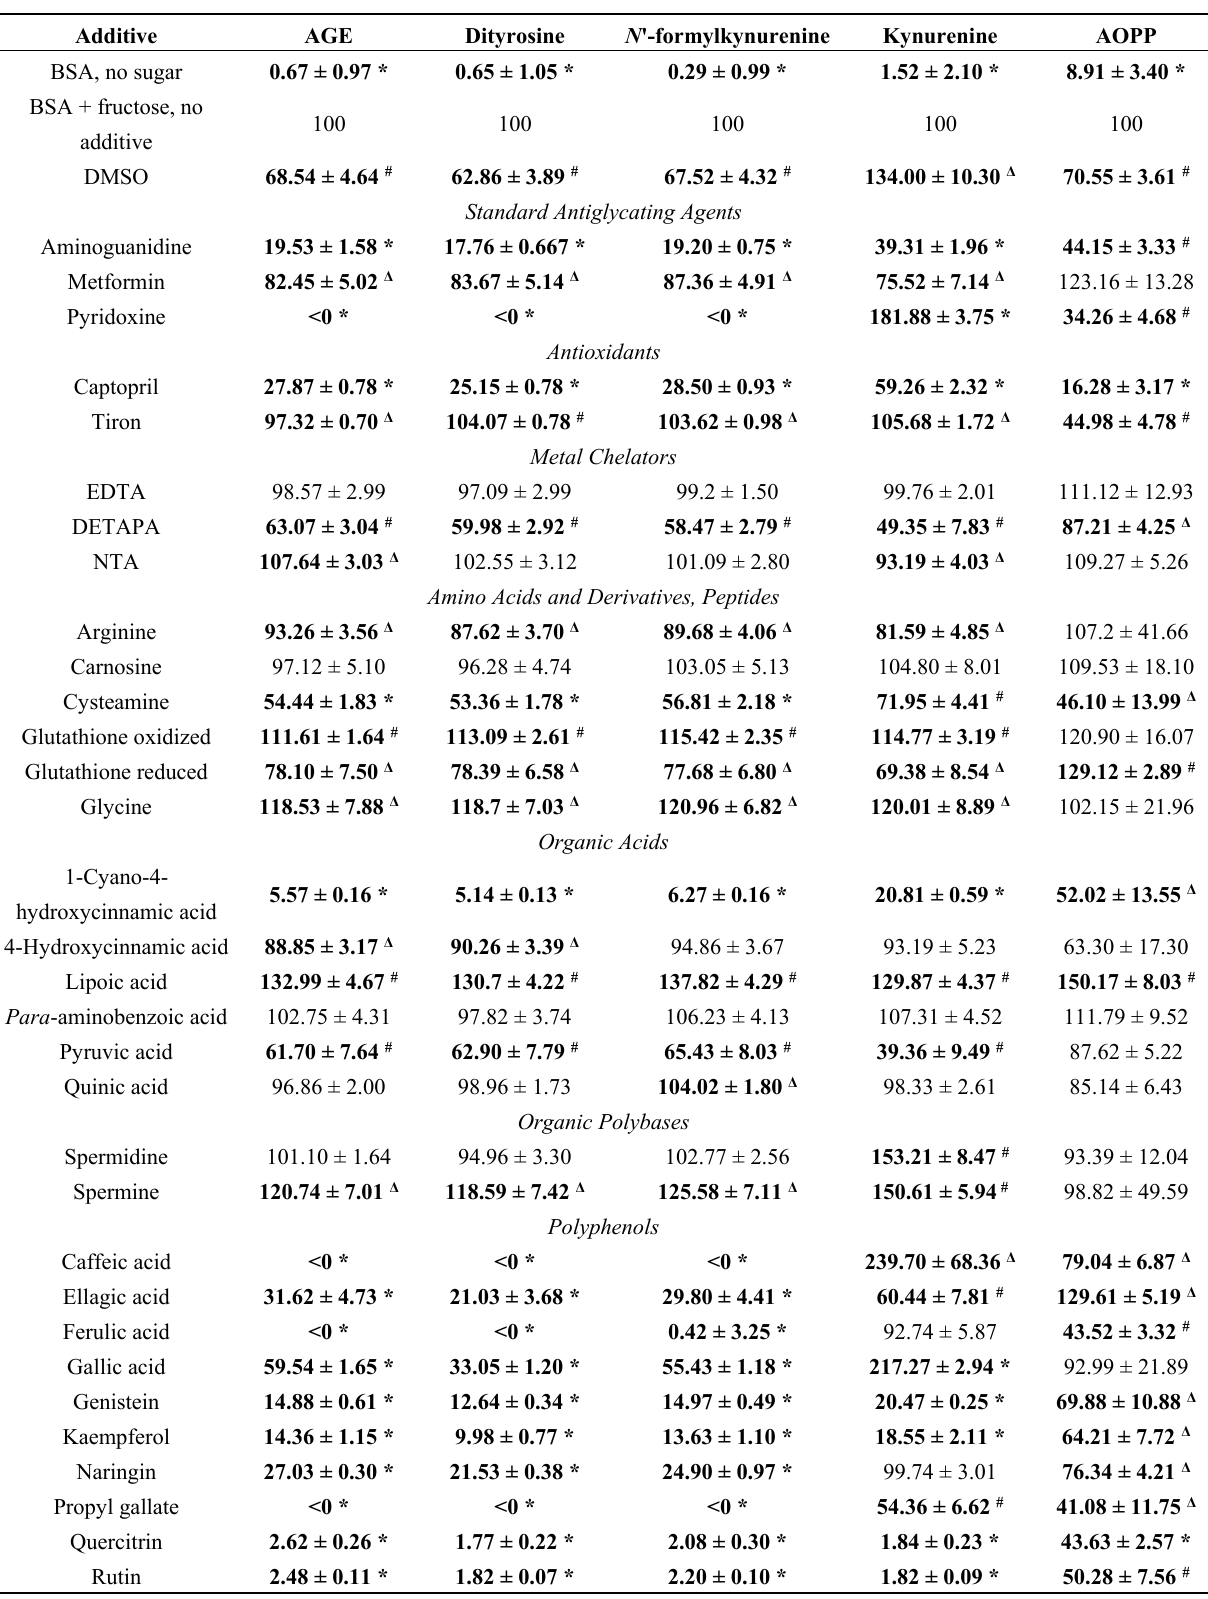
Table 2. The effect of various additives (1 mM) on the extent of the glycoxidation of BSA induced by fructose (0.5 M), estimated with fluorometric parameters. Δ p < 0.05, # p < 0.01, * p < 0.001 (paired Student’s t